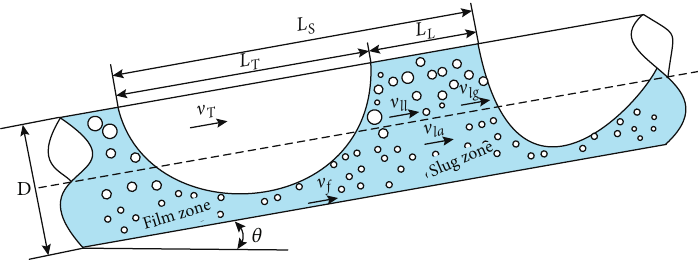
Figure 1: Geometric model of the slug fl ow in the inner section of the slightly inclined